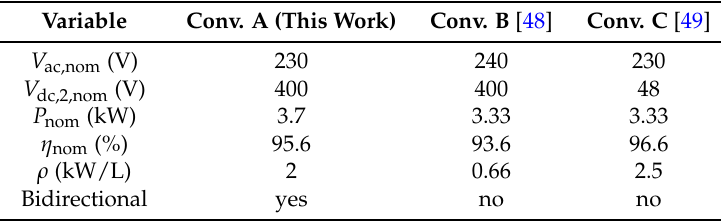
Figure 26. Comparison of the efficiency of the presented 1-S DAB ac-dc converter (black line; converter A) and the efficiency of two state-of-the-art dual-stage converter systems reported in literature: converter B presented in [48] and converter C presented in [49]. Table 4. Characteristic comparison of the presented 1-S DAB ac-dc converter (converter A) and the two state-of-the-art dual-stage converter systems reported in literature: converter B presented in [48] and converter C presented in